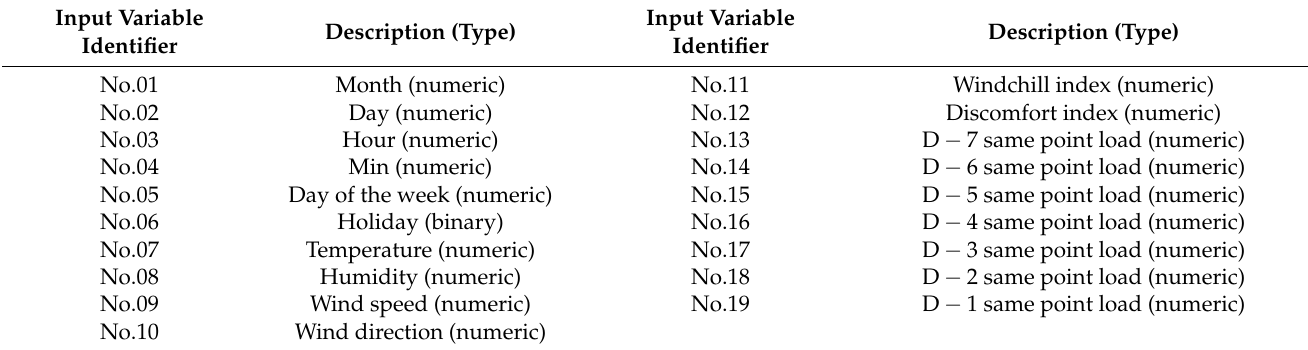
Table 1. List of input variables for the proposed